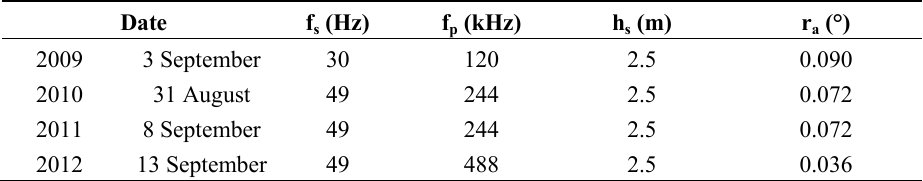
Table 1. System parameters for the mobile laser scanning acquisitions at different time = scanning frequency, f = point measurement frequency, h points (f s p = angular from the water surface, and r a